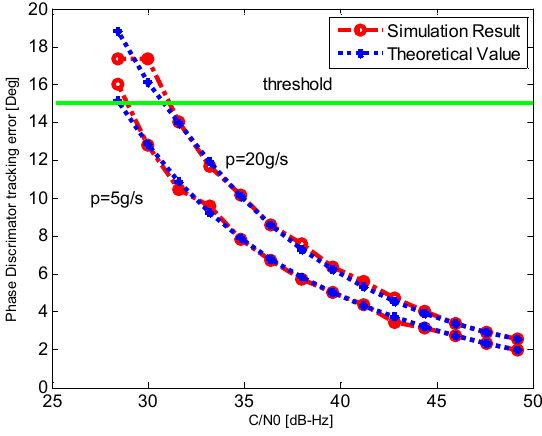
Figure 9. The PD tracking error for different C / N 0 .